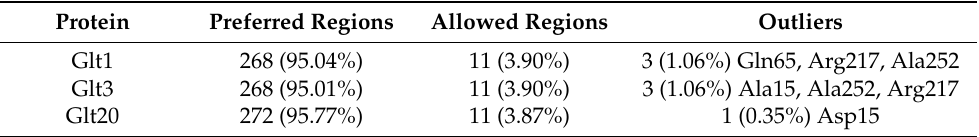
Table 1. Ramachandran diagram